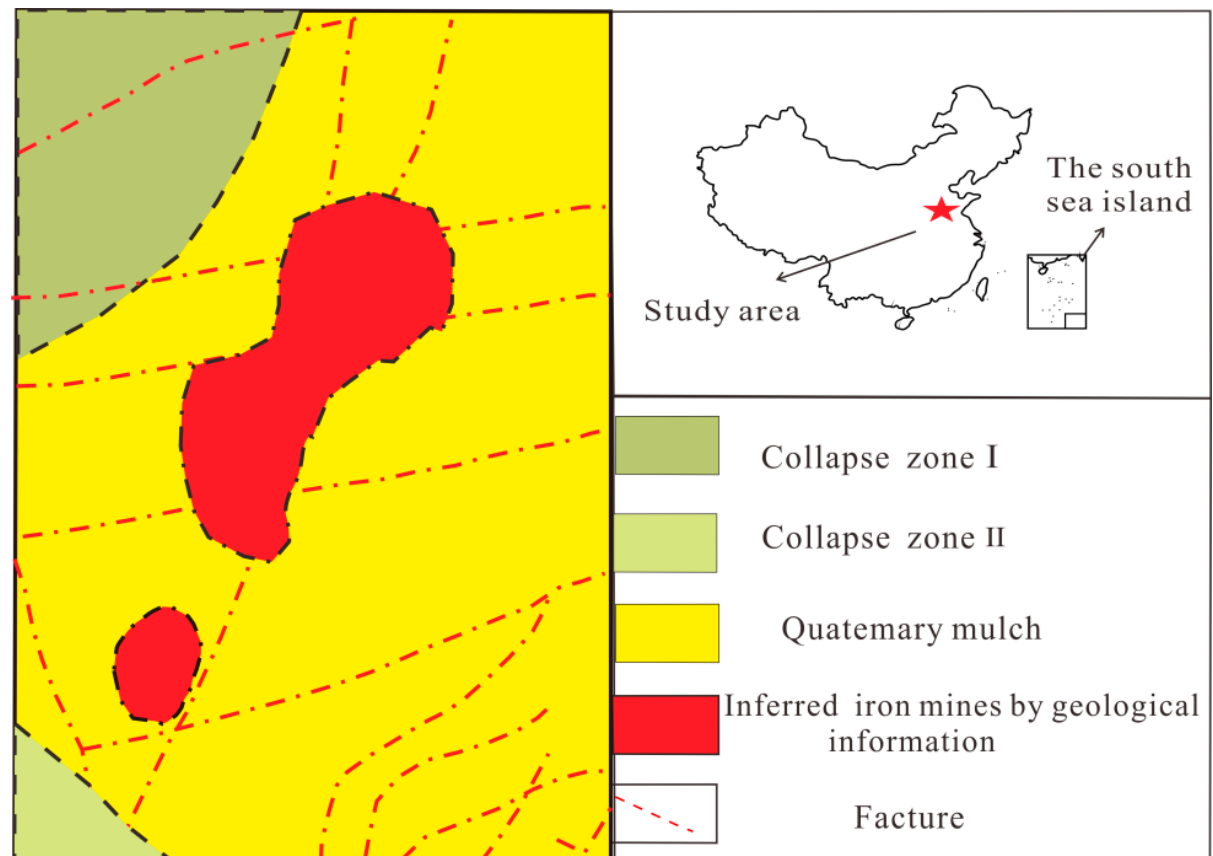
Figure 7. Geological map of the research area.